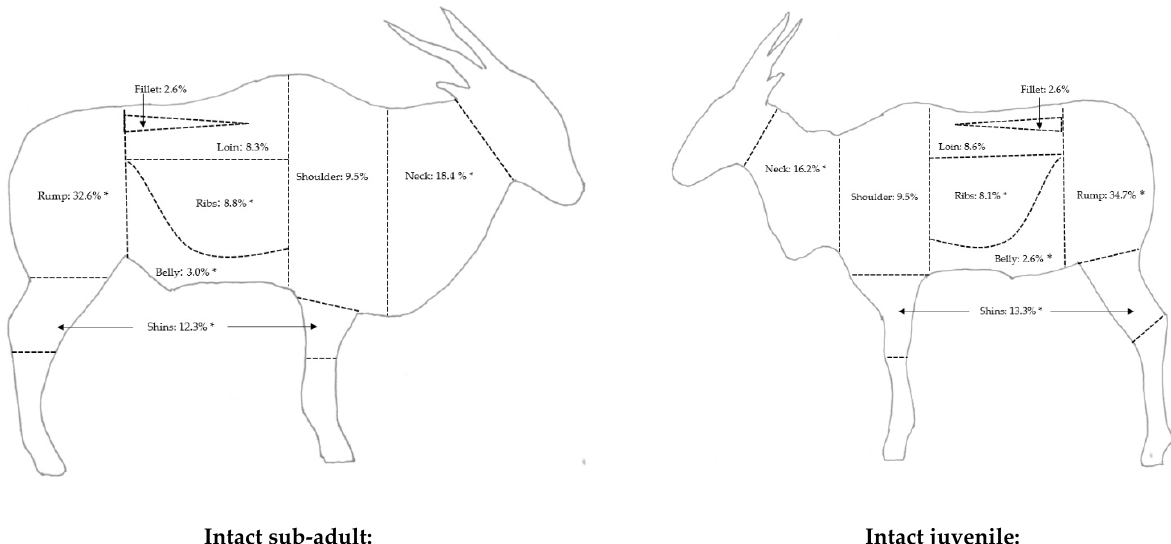
Figure 1. The primal cut yields (as a % of cold side weight) of sub-adult and juvenile common eland males. * indicates significant differences at p < 0.05.